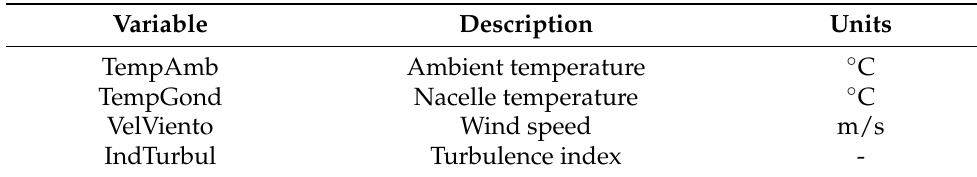
Table 2. Environmental